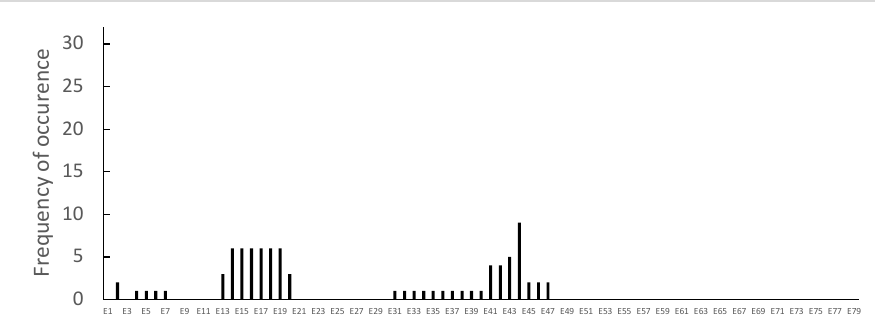
Figure 9. Frequency of single exon duplications in the dystrophin gene observed in BMD patients. Fourteen patients with BMD (5.2%) had point mutations that were localized in exons E29 (3), E70 (1) or in introns I62 (9) or I75 (1). The pathogenic variant located in intron 62 affected nine members of the same family, in three generations.